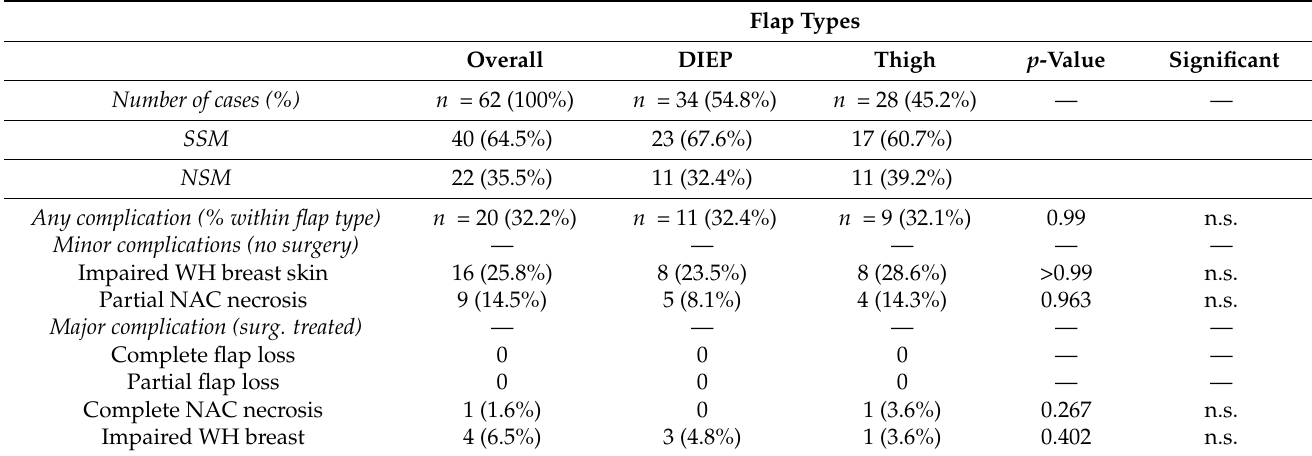
Table 2. Univariate Comparison of Breast-Site Complications between DIEP and Thigh groups.